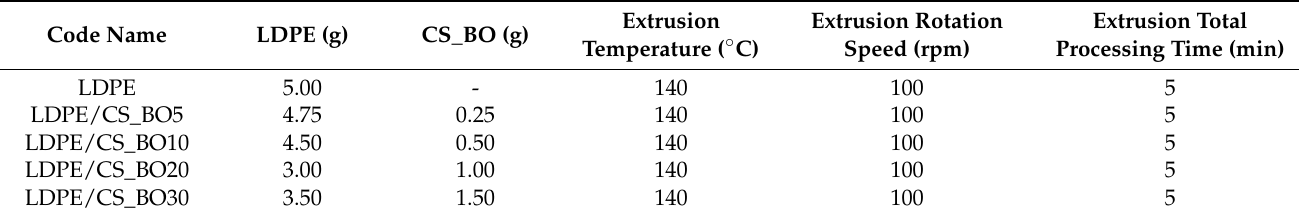
Table 4. Code names and amounts of the used LDPE and CS_BO. Extrusion processing conditions for all the prepared active